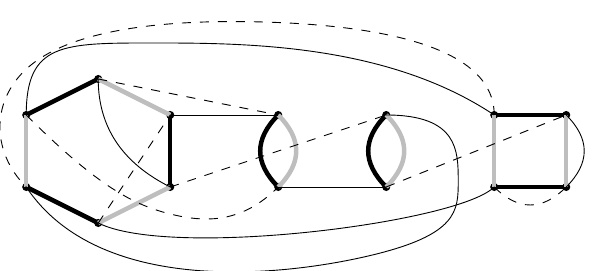
Figure 10 . The graph G = A [ B with P and Q . The thick black edges are A , the thick grey edges are B , the thin black edges are P and the dashed edges are Q